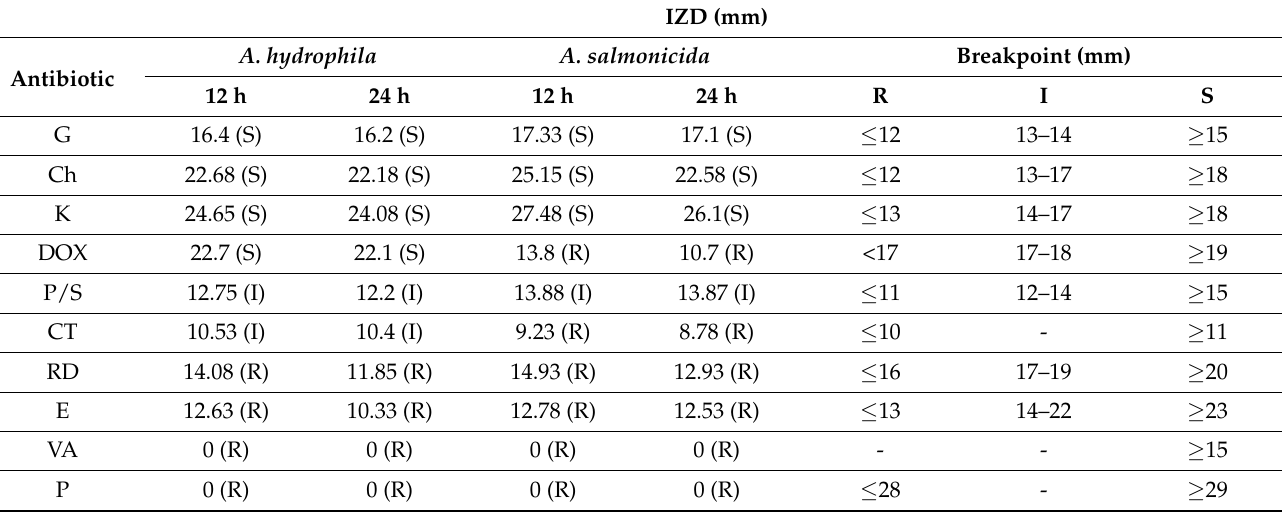
Table 1. Susceptibility (IZD) of Aeromonas spp. to